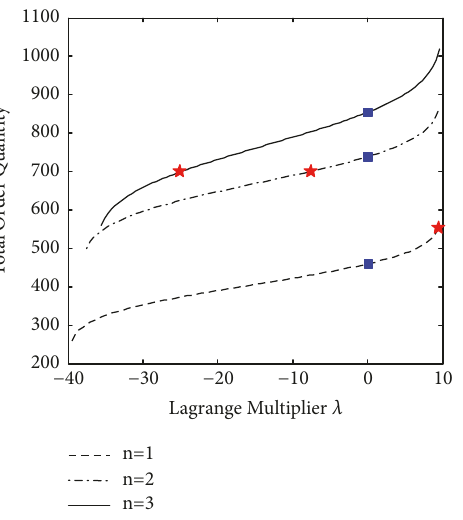
Figure 2: Retailer’s total order quantity. Figure 3: Retailer’s expected profit.